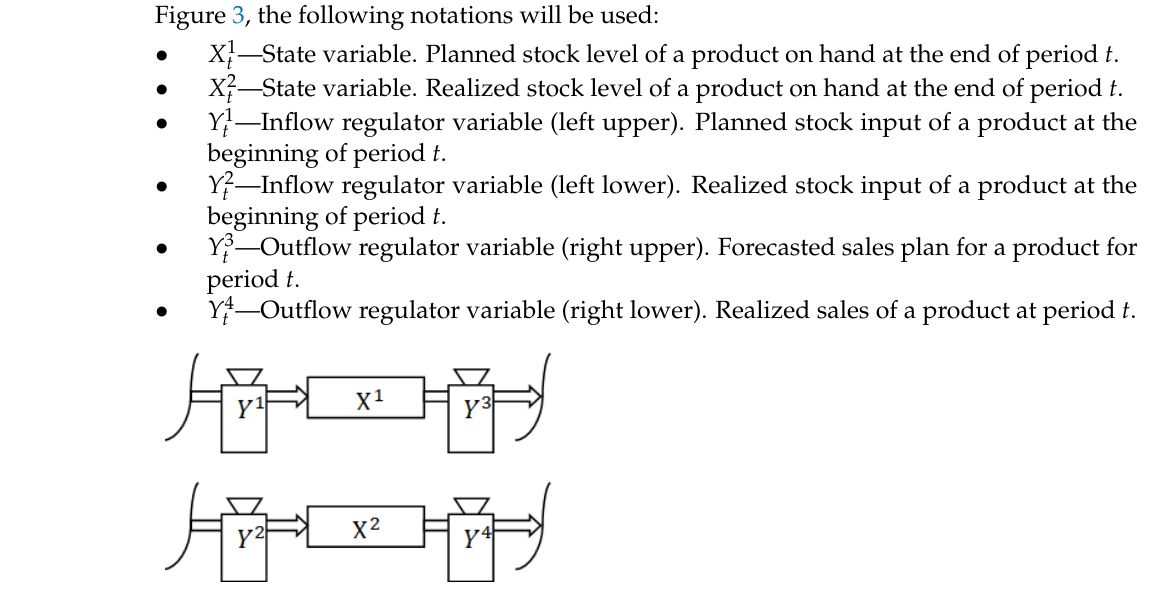
Figure 3. Graphical representation of information and material flows.